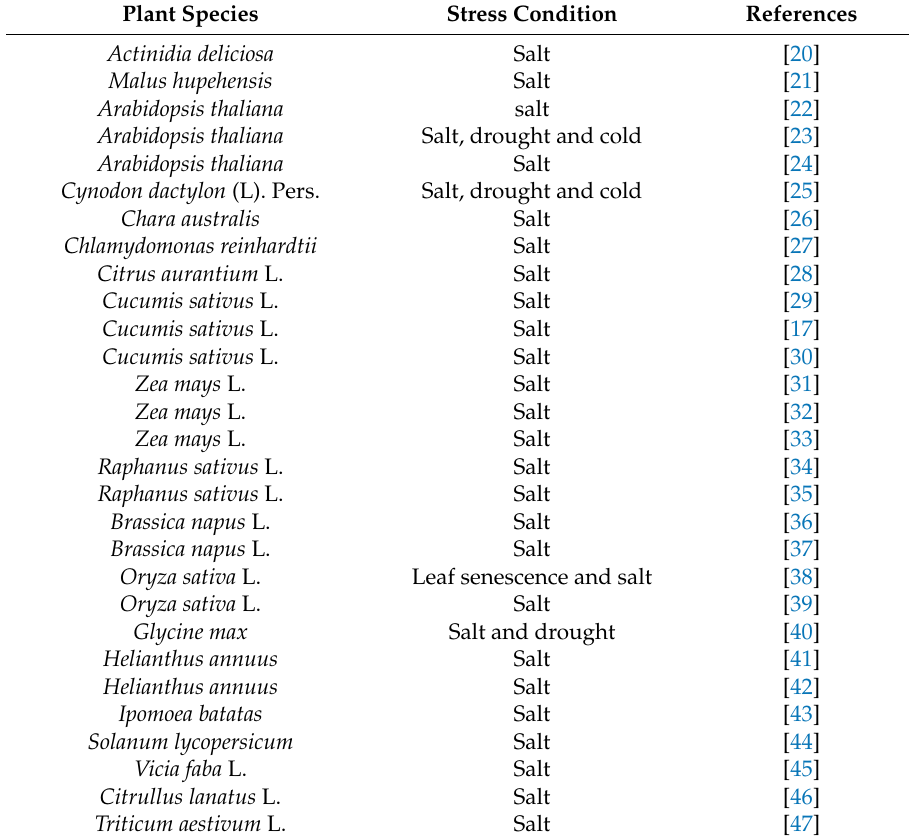
Table 1. The reported roles melatonin plays in response to salt and other stresses in plants. Plant Species Stress